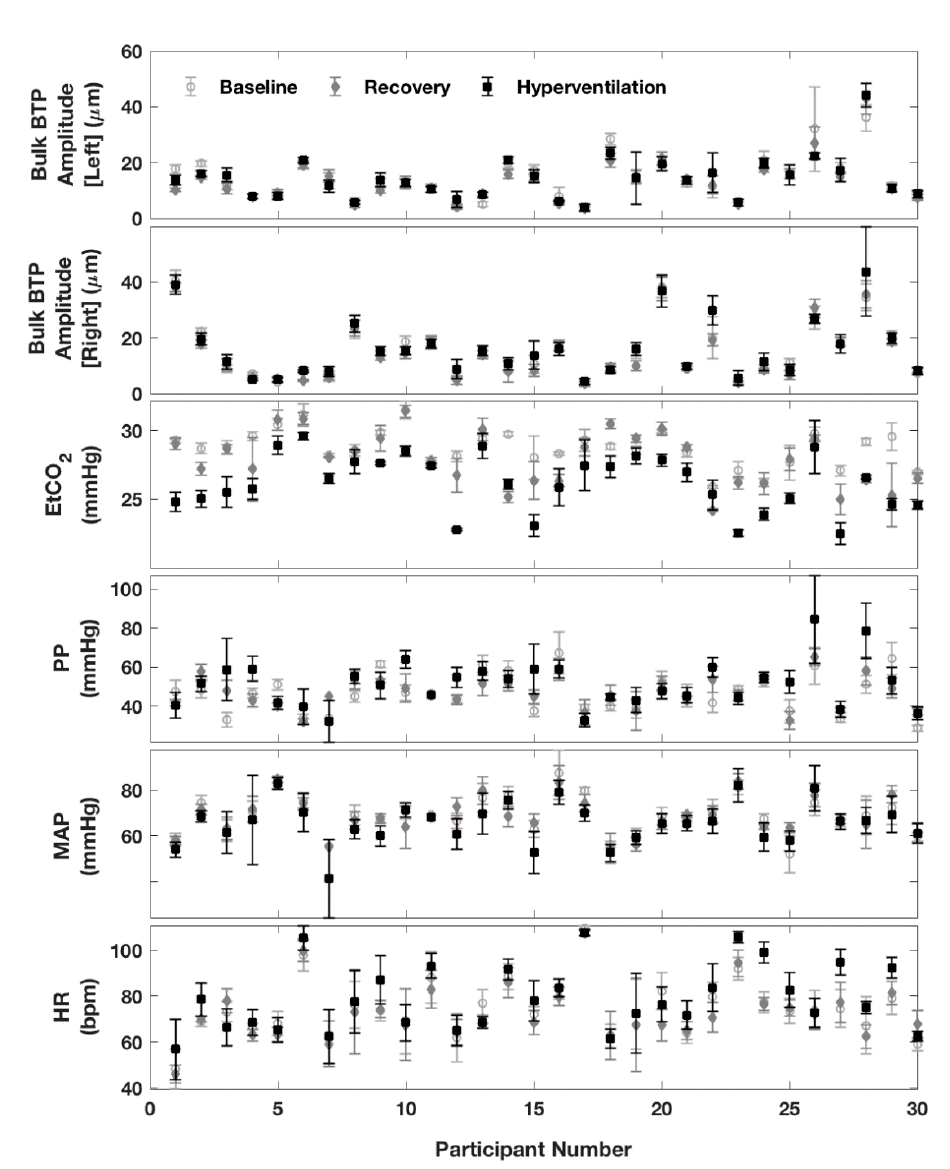
(i.e., baseline versus recovery) confirmed no significant di ff erences in PP, MAP, or HR, confirming the transient reversible nature of induced changes.